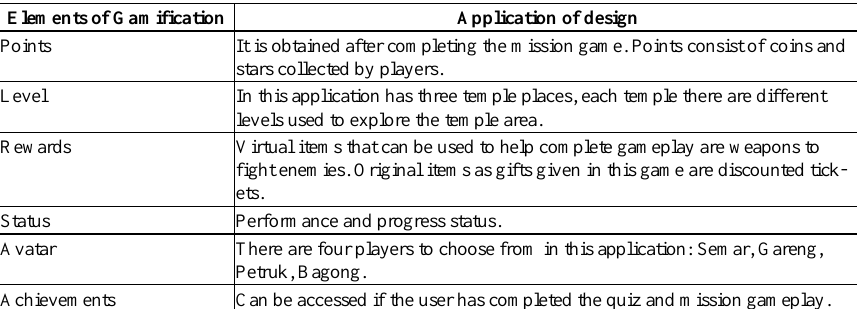
Table 4. The results of the user's